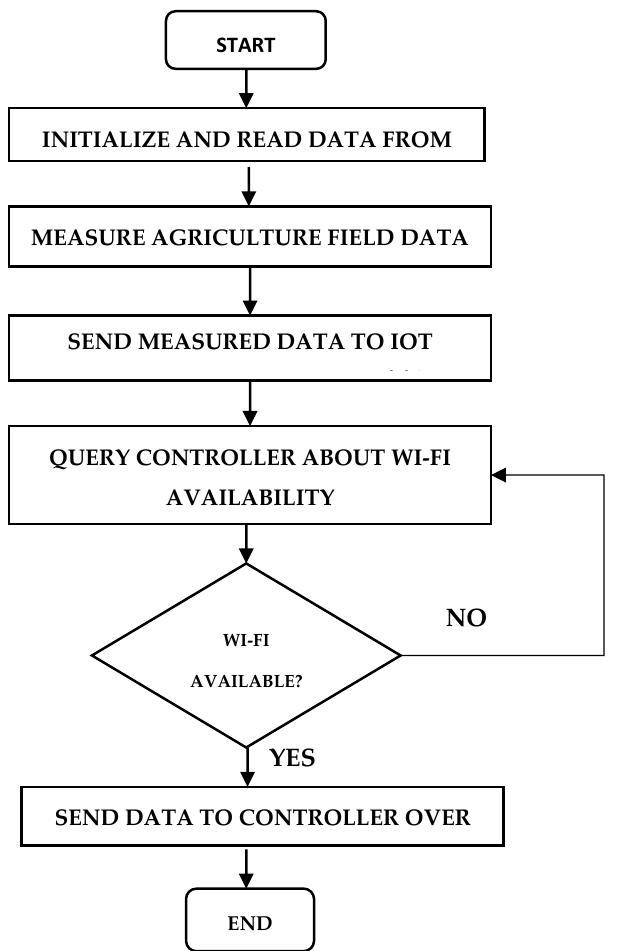
Figure 4. Workflow of experimental model.